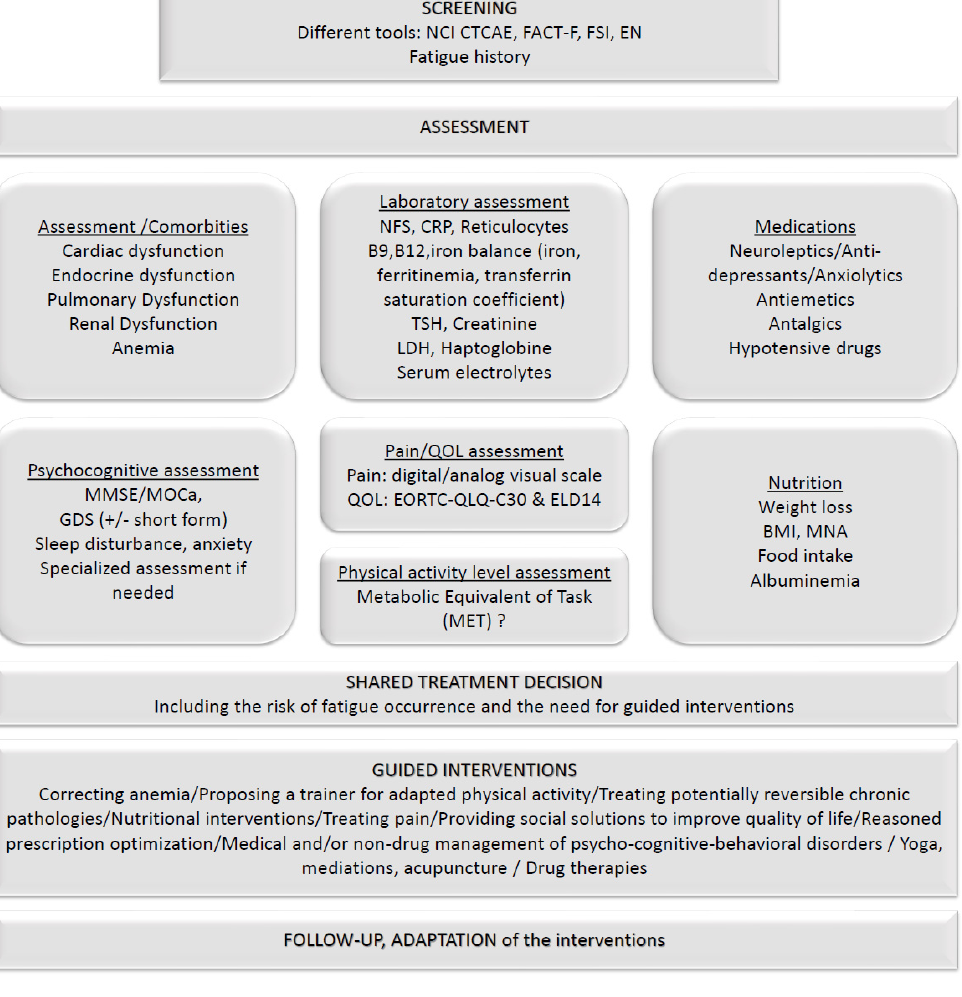
Figure 3. A proposed work-up on comprehensive (geriatric) assessment of fatigue.